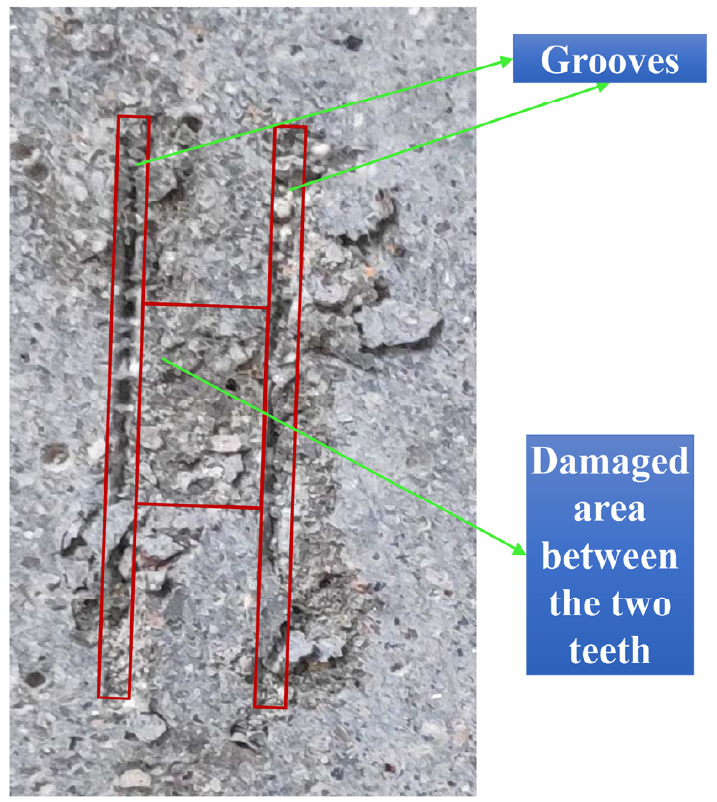
Figure 10. Grooves and damaged area between the two teeth.